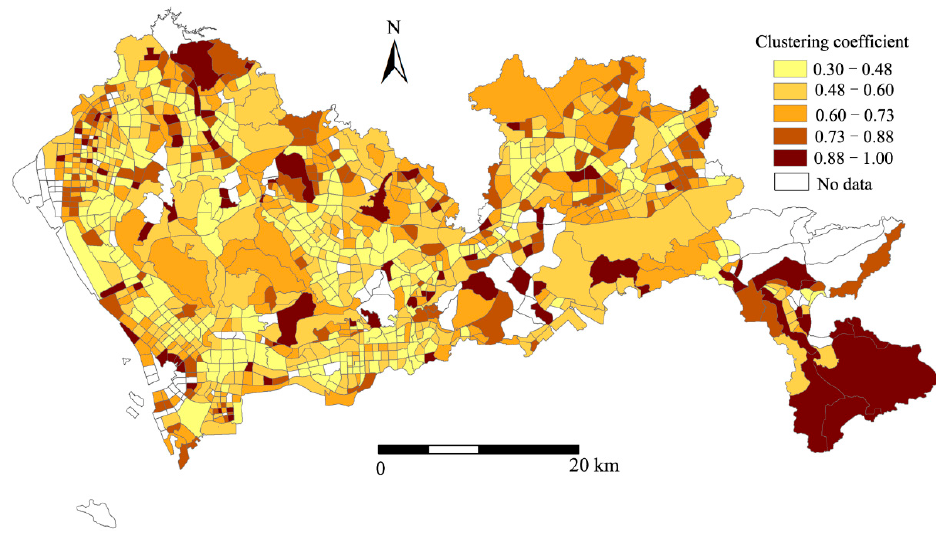
Figure 5. Spatial distribution of the clustering coefficient.